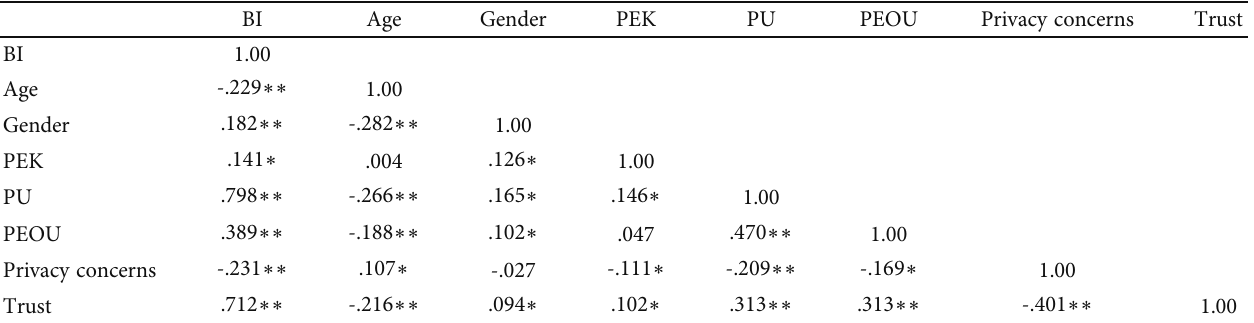
Figure 2: Mean scores. Table 2: Pearson correlation coe ffi cients of mental health care scales.